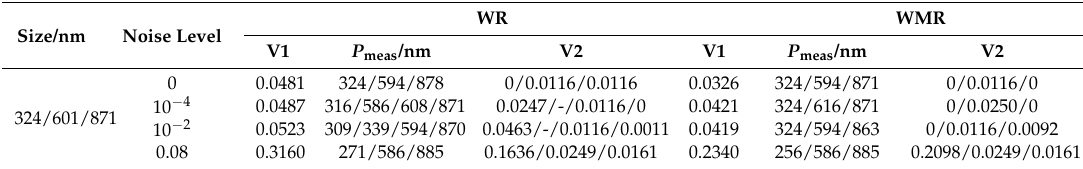
Table 4. The performance indices of the inversion for simulated 324/601/871 nm trimodal DLS data under different noise